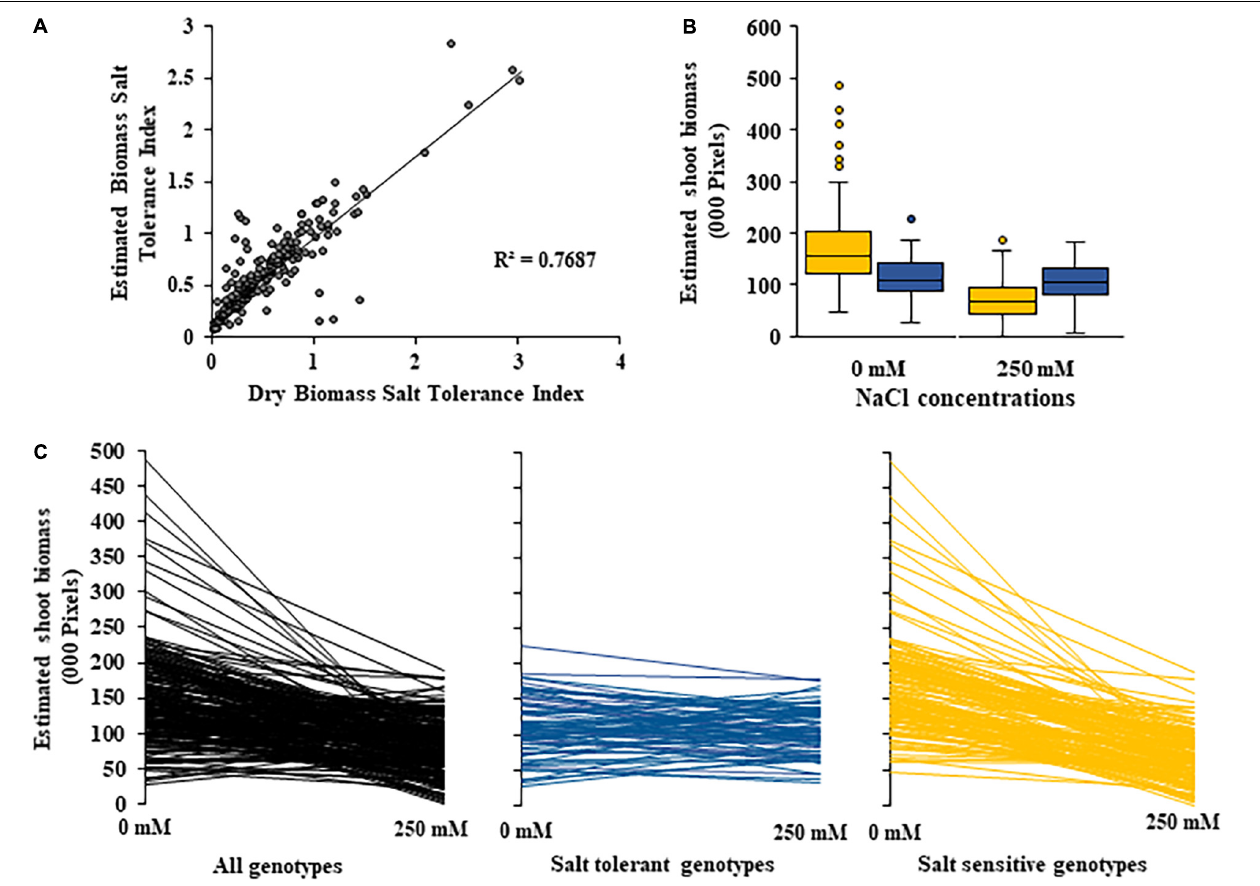
FIGURE 4 | Changes in shoot biomass between control and salt (NaCl) treatments for 200 diverse safflower genotypes. (A) Correlation between estimated biomass and dry biomass salt tolerance index. (B) Boxplots showing spread of estimated shoot biomass data for safflower genotypes classified as salt tolerant (blue) or salt sensitive (yellow) based on dry biomass salt tolerance index. Boxplot plots represent minimum, maximum and mean values as well as interquartile range and outliers. (C) Estimated shoot biomass under control (0 mM) and salt (250 mM) treatments for 200 diverse safflower genotypes. Black – all genotypes; blue – salt tolerant genotypes n = 65; and yellow – salt sensitive genotypes n =